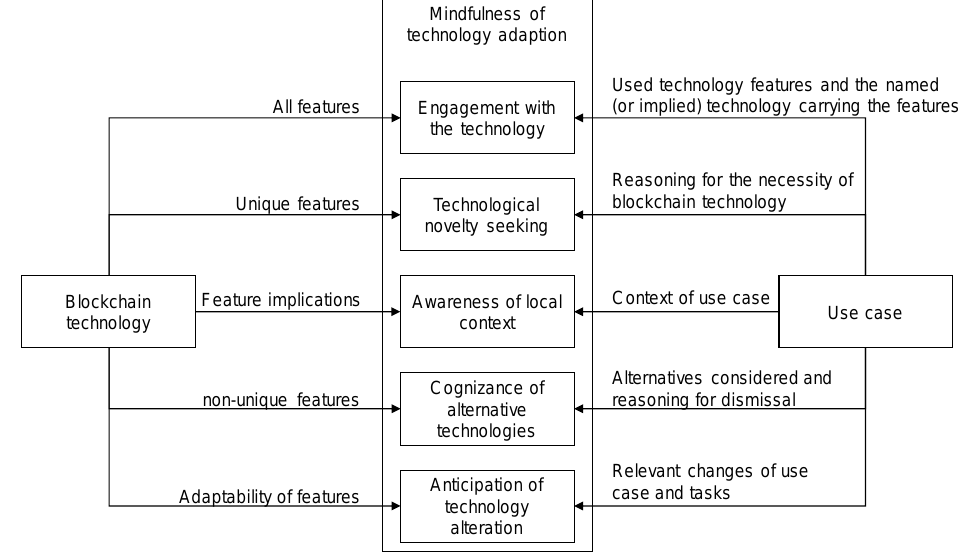
Figure 1. Framework to evaluate the mindful use of blockchain technology in LSCM.